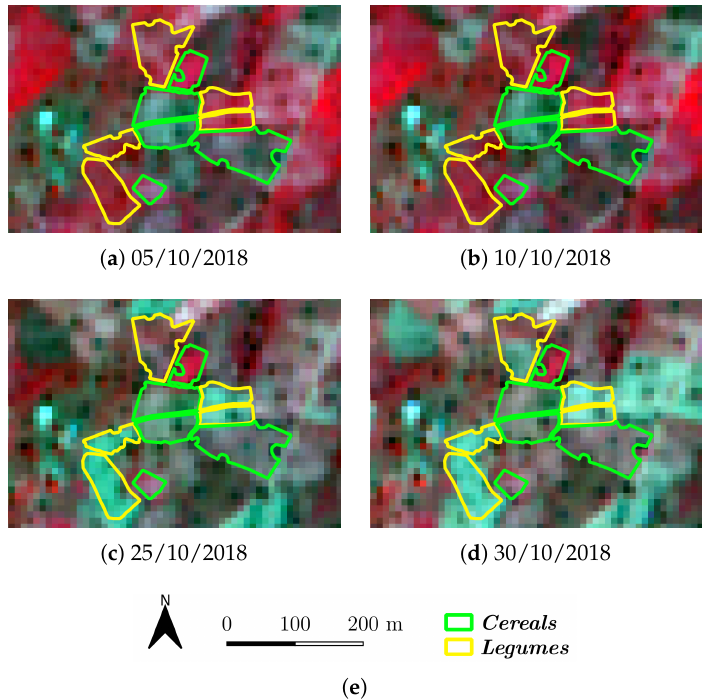
Figure 17. Visualization of end of season agricultural practices in the Senegalese groundnut basin concerning cereals and legumes land covers. Background images come from the Sentinel-2 time series and are displayed in Green–Red–Infrared composite